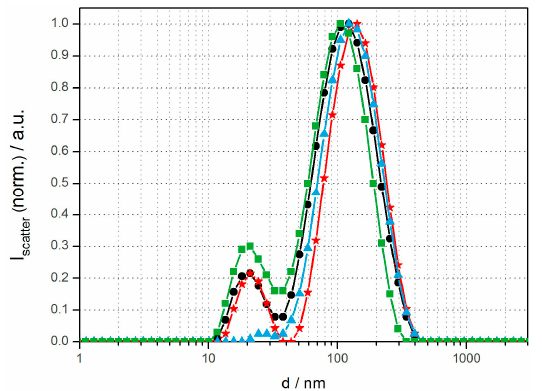
Figure 1. DLS size distributions of various magnetopolymersomes (10% w/w SPION) prepared via solvent inversion at 2 mg/mL plus homogenization via extrusion through 100-nm polycarbonate membranes (Avestin): PBD(1200)- b -PEO(600)-OH (black), PBD(1200)- b -PEO(600)-COOH/ b -PEI(800) (100% n/n ) (red), PBD(1200)- b -PEO(600)-DEDETA (50% n/n ) (blue) and PBD(1200)- b -PEO(600)- OH/DOEPC (30% n/n ) (green).